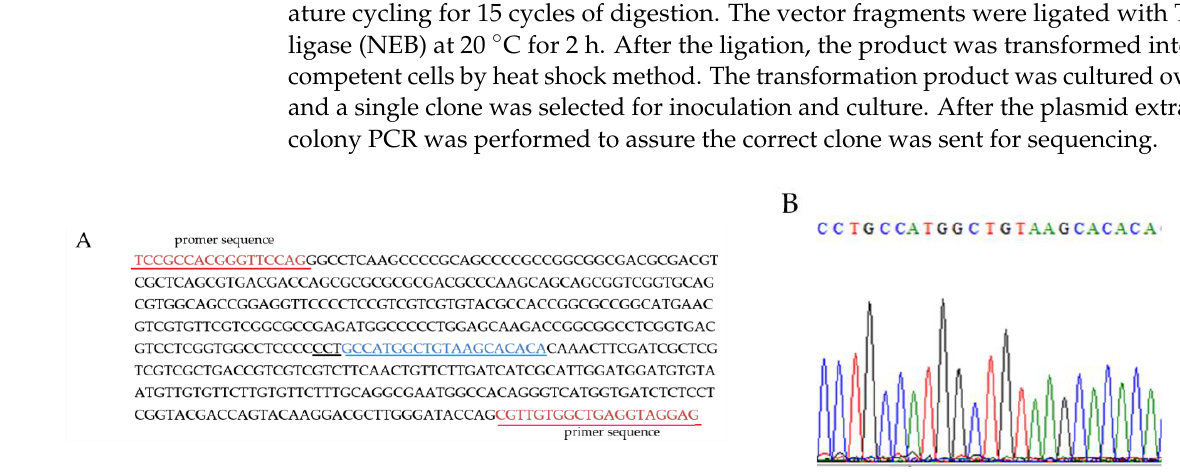
Figure 1. Location single guiding RNA (sgRNA) in the Wx gene and designed primers for amplification. ( A ) Wx gene partial sequence showing target positions and primer sequences; red nucleotides represent the upstream and downstream primers; black underlined nucleotides denote the protospacer adjacent motif (PAM) region; blue nucleotides show sgRNA sequences. ( B ) Sequencing peak map of sgRNA.